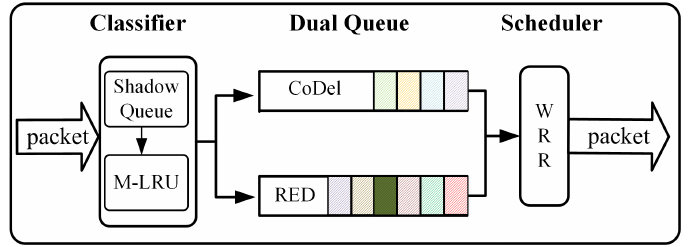
Figure 4. The big picture of SQM-LRU’s design.